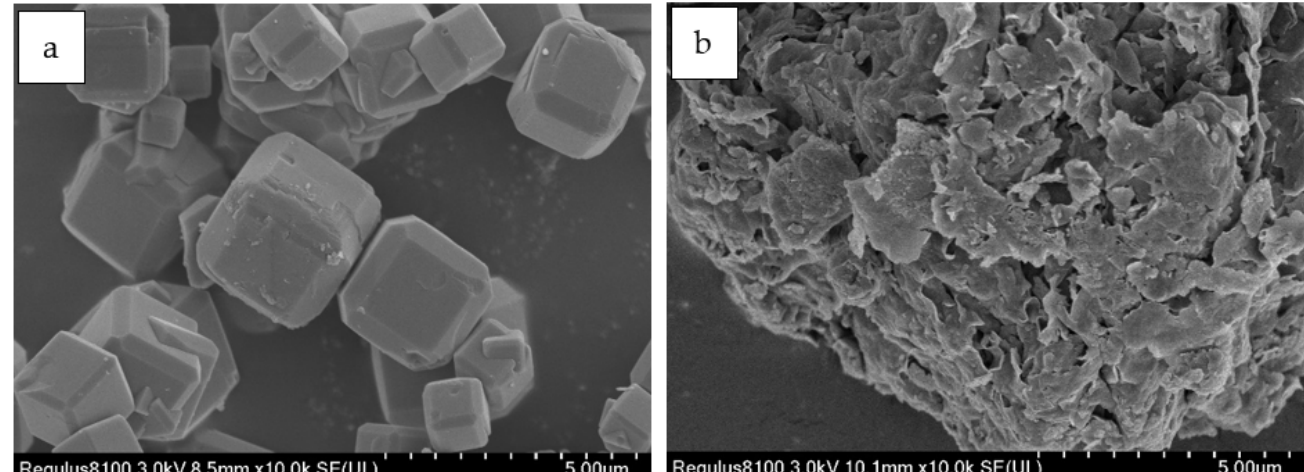
Figure 2. SEM images of Linde type A zeolite ( a ) and montmorillonite ( b ).